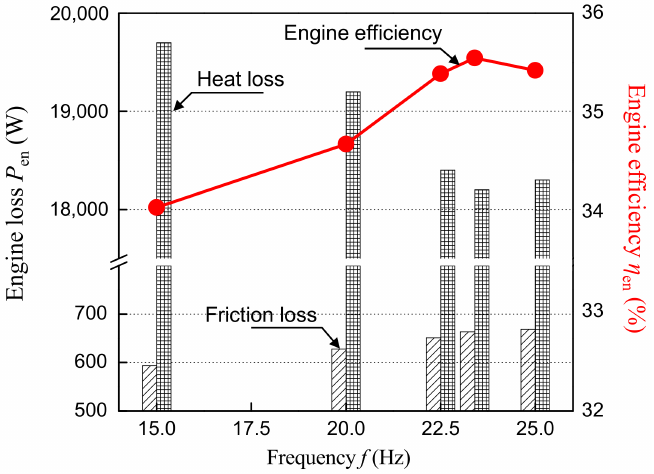
Figure 6. Relationship between the action frequency of the mover, thermal loss, friction loss, and engine